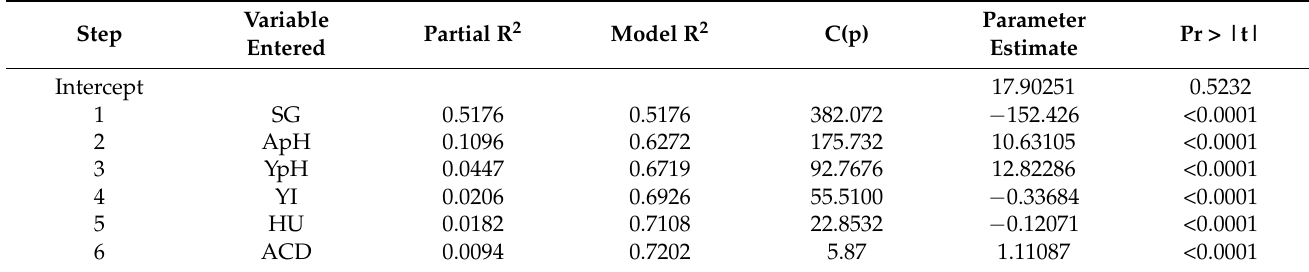
Table 3. Statistical model used to predict the age of the eggs (in